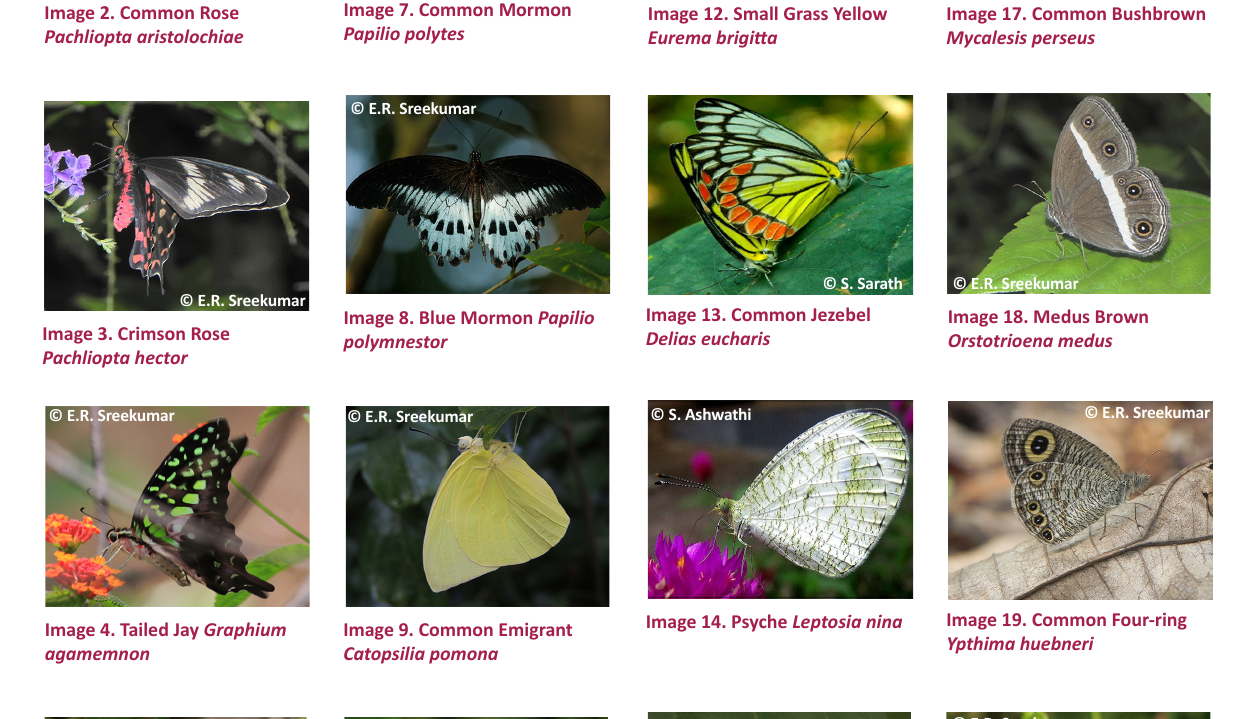
Image 17. Common Bushbrown Mycalesis perseus